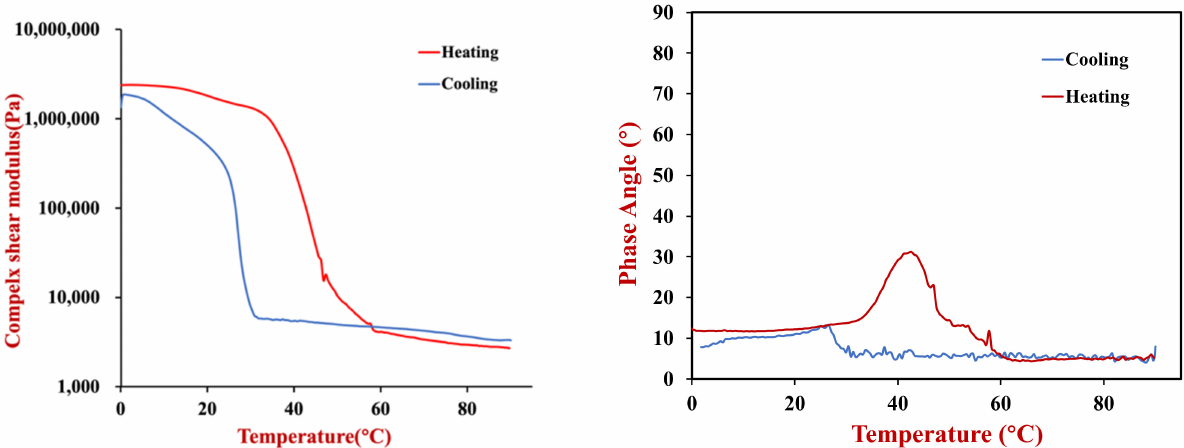
Figure 3. Temperature dependence of the complex shear modulus ( left ) and phase angle ( right ) of beef adipose tissue measured using dynamic shear rheometry (1 Hz, 0.1%